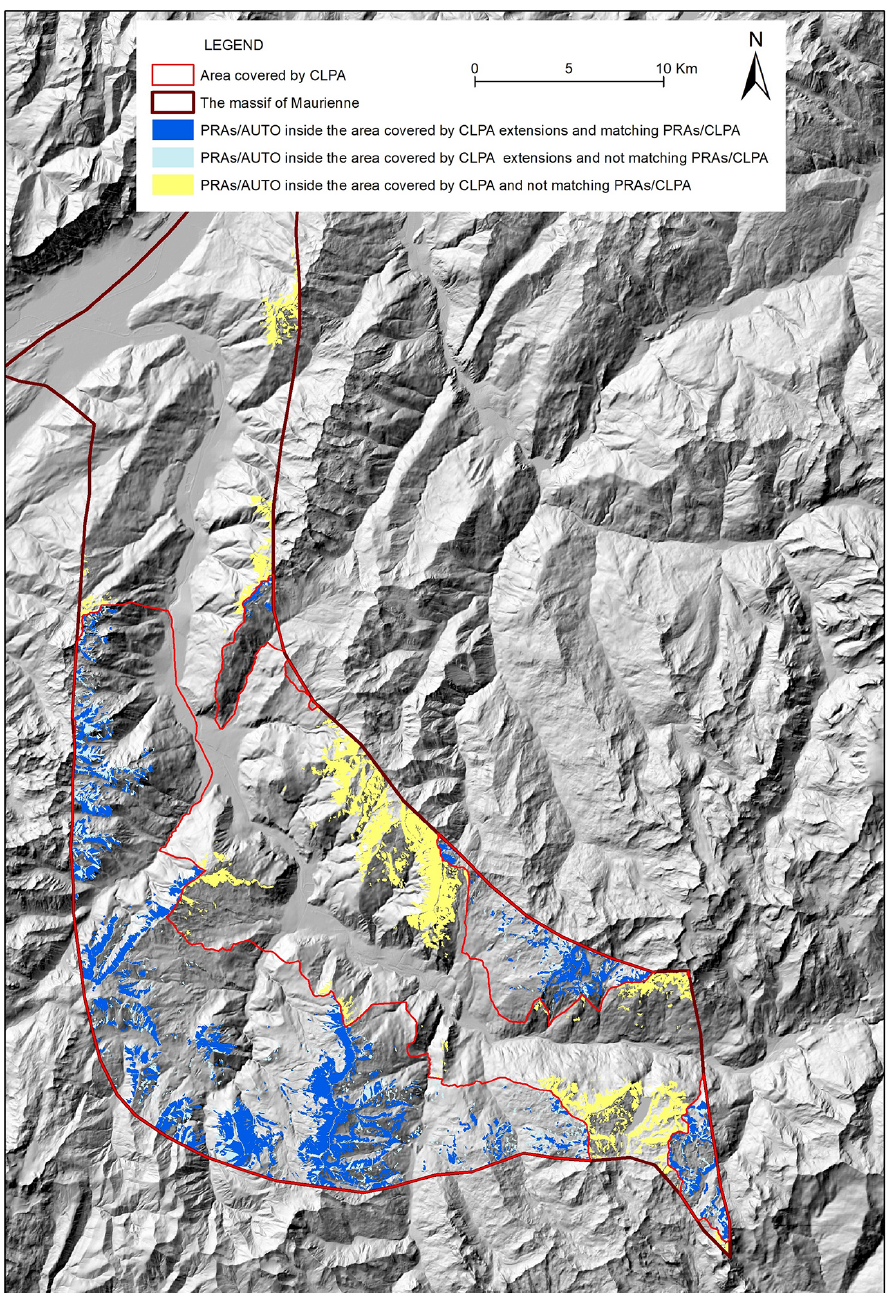
Figure 8. Result of the proposed PRA detection method for the entire Maurienne massif. Digital elevation model © IGN. For the PRA detection and the determination of the validation sample, all factors and the DEM resolution are set to their default values (Figs. 3–4), and forest cover data are from DB forest IGN. “CLPA extensions” refer to avalanche extents from the French avalanche